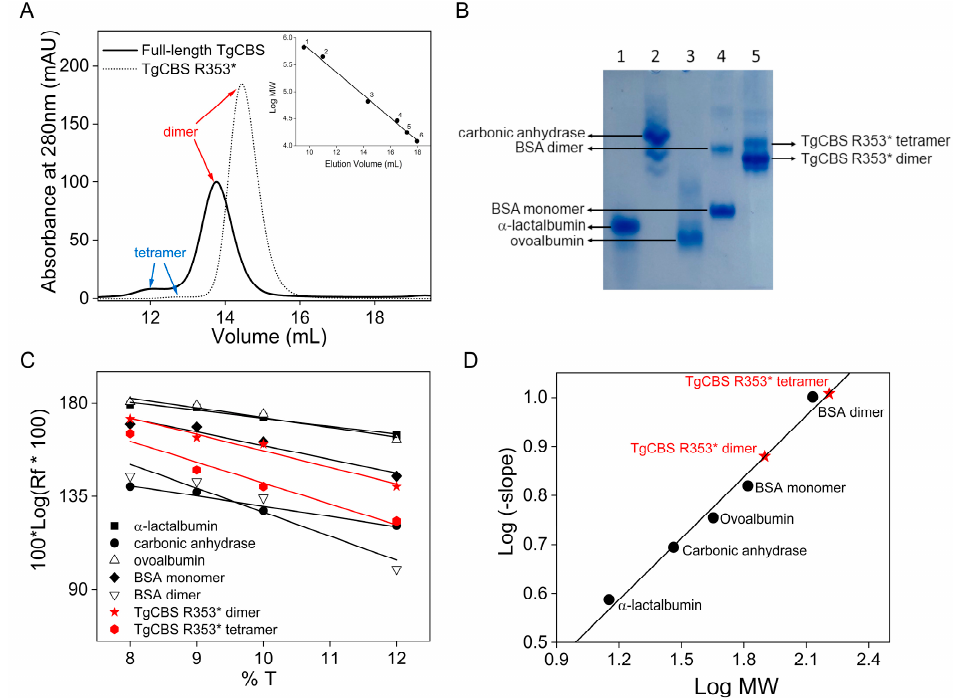
Figure 3. Oligomeric state of TgCBS R353*. ( A ) Gel filtration chromatography of full-length TgCBS (solid line) and TgCBS R353* (dotted line) at 1 mg/mL using a Superdex 200 10/300 GL column in 20 mM sodium phosphate buffer pH 8.5, 150 mM NaCl and 0.1 mM DTT. Inset, calibration curve of the logarithm of the molecular weight versus elution volumes. The standard proteins used were: 1, thyroglobulin; 2, apoferritin; 3, albumin bovine serum (BSA); 4, carbonic anhydrase; 5, myoglobin; 6, cytochrome c. ( B – D ) Relative electrophoretic mobility calculation of TgCBS R353* dimer and tetramer by Ferguson plot. ( B ) Representative native-PAGE (8% T) showing the mobility of standard proteins and TgCBS R353*. Lane 1: α -lactalbumin; Lane 2: carbonic anhydrase; Lane 3: ovoalbumin; Lane 4: BSA (dimer and monomer); Lane 5: TgCBS R353*. ( C ) Effect of %T on the relative mobility of standard proteins and TgCBS R353*. Plot of 100 [log (Rf × 100)] versus %T, according to Ferguson et al. [27]. ( D ) Standard curve was obtained by plotting the log of the negative slope (from ( C )) against the log of standard proteins’ molecular weight.